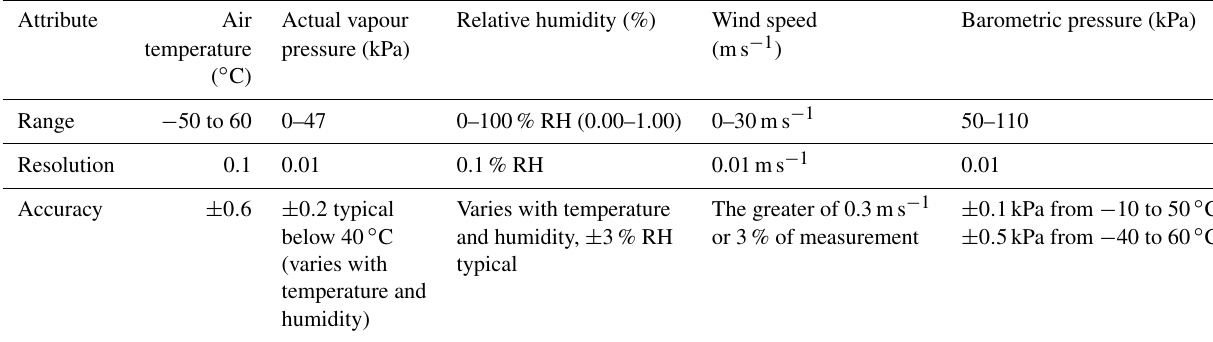
Table A2. Selected ATMOS 41 sensor specifications.